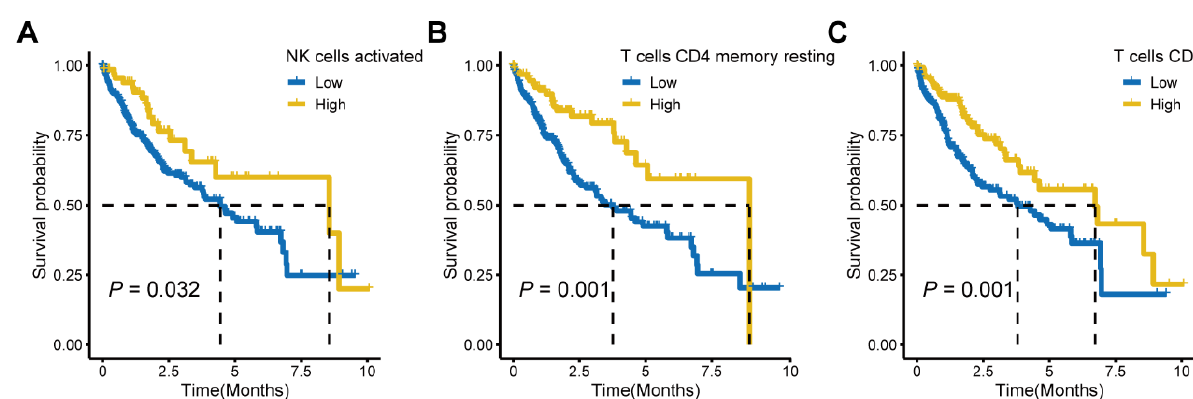
Figure A1. ( A – C ): KM curves of di ff erent immune-related cell types.